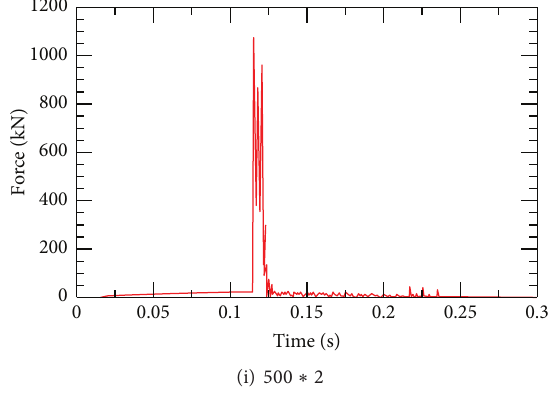
Figure 11: Impact-time curve of slab.